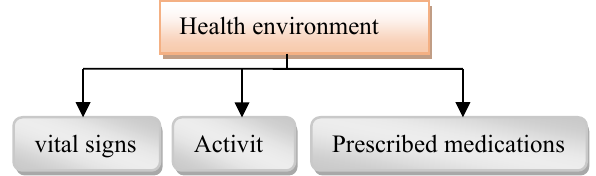
Figure 1 . Context in computing system